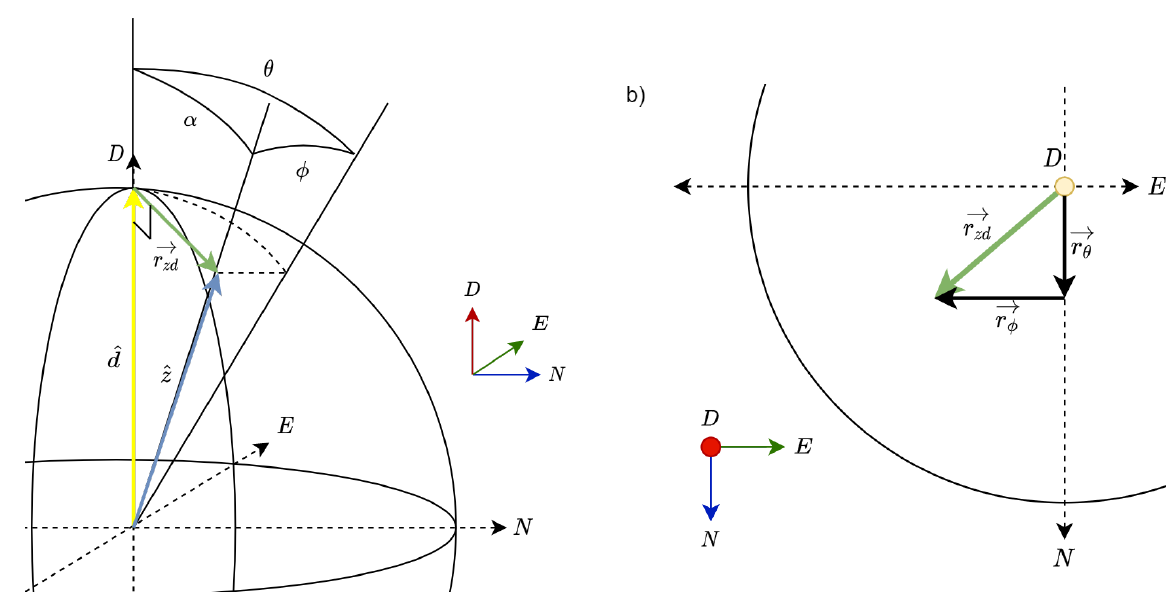
Figure 5. Geometrical representation of a buoy’s rotation in the roll and pitch dimensions of movement and vector approximation for small angles: ( a ) three-dimensional geometry sketch showing eigenangle α , roll ( φ ), and pitch ( θ ) angles and vectors ˆ d and ˆ z in an NED coordinate system. ˆ d transforms into ˆ z after the roll ( φ ) and pitch ( θ ) rotations about the N and E axes, respectively (Equation (12)). ( b ) Representation of roll and pitch rotations (cid:126) r φ and (cid:126) r θ , respectively, on the NE plane (Equation (10)) along with the resultant vector (cid:126) r zd (Equation